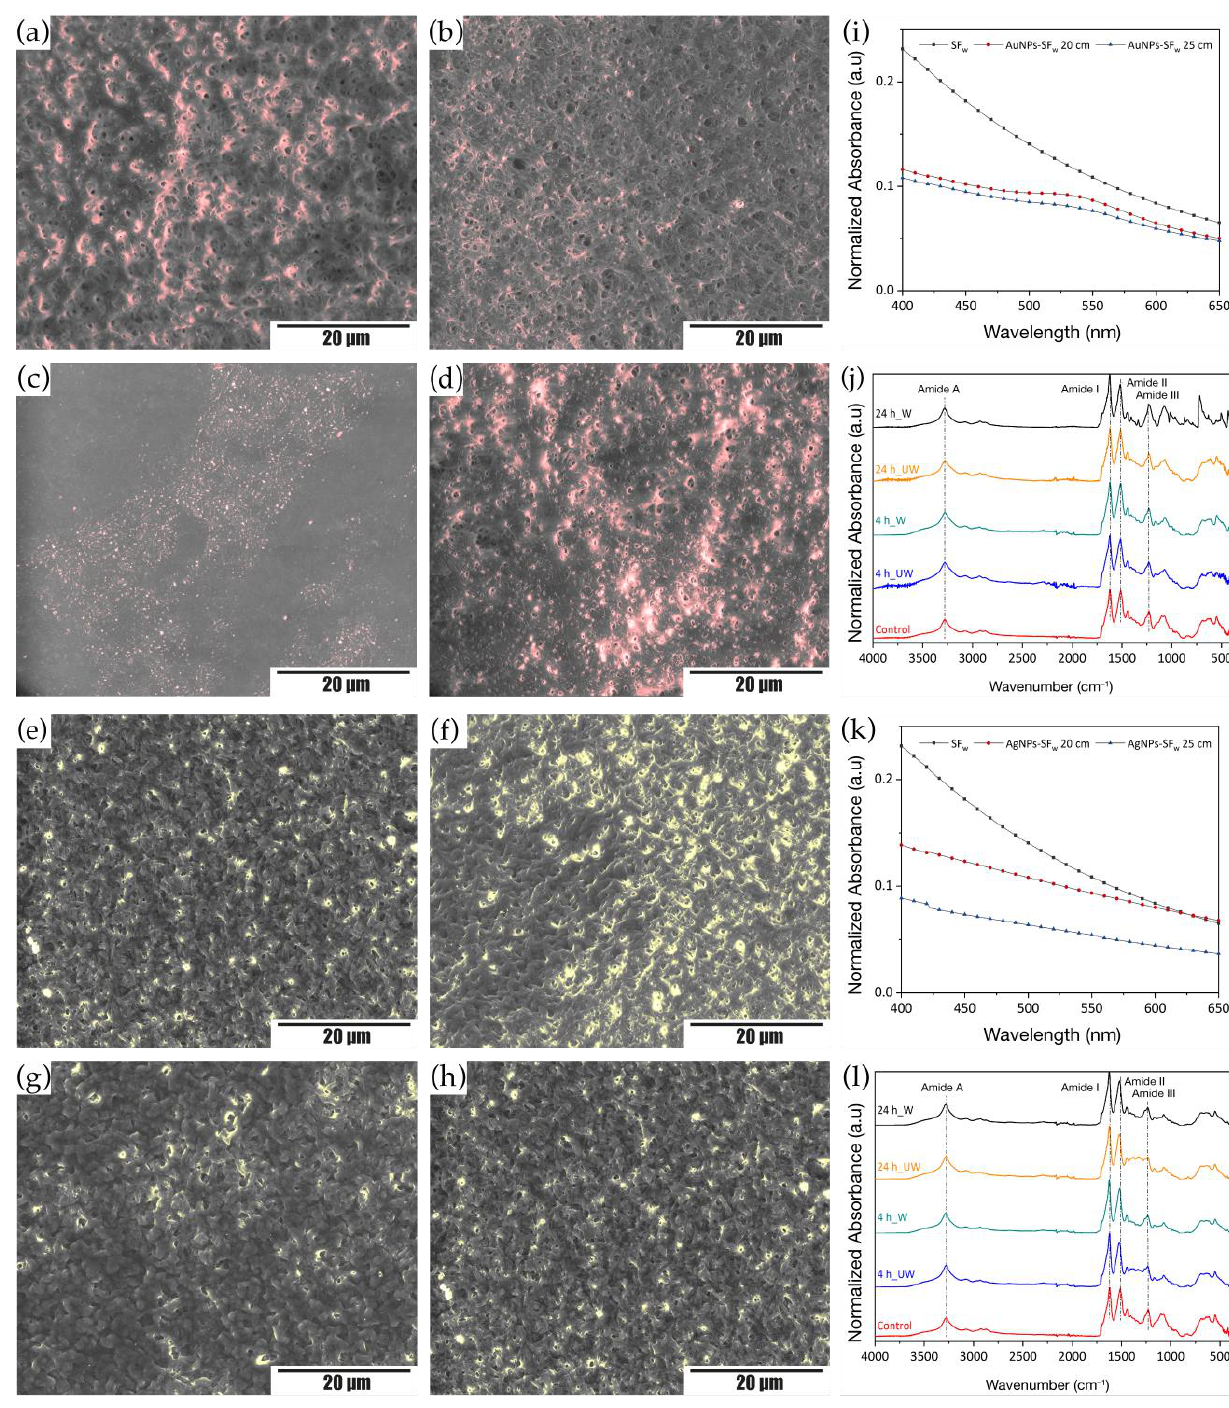
Figure 4. STEM micrographs of treated SF w membranes and functionalized by impregnation coating for 4 h and 24 h with and without washing. Where ( a , b ) with AuNPs-SF w with washing; ( c , d ) with AuNPs-SF w without washing; ( e , f ) with AgNPs-SF w with washing; ( g , h ) with AgNPs-SF w without washing. Scale bar, 20 μm. UV -Visible absorption spectra of treated and functionalized SF w mem- branes. Where ( i ) AuNPs-SF w and ( k ) AgNPs-SF w . A SF w membrane without impregnation coating was used as a control. FTIR-ATR absorption spectra obtained from treated and functionalized SF w electrospun membranes. Where ( j ) AuNPs-SF w and ( l ) AgNPs-SF w . Non-functionalized treated SF w membranes were used as controls. Where UW — unwashed and W — washed. Table 3. Secondary structures present in the vibrational mode of amide I for the treated membranes and functionalized with AuNPs-SF w and AgNPs-SF w for 4 h and 24 h. Non-functionalized treated SF w membranes were used as controls.